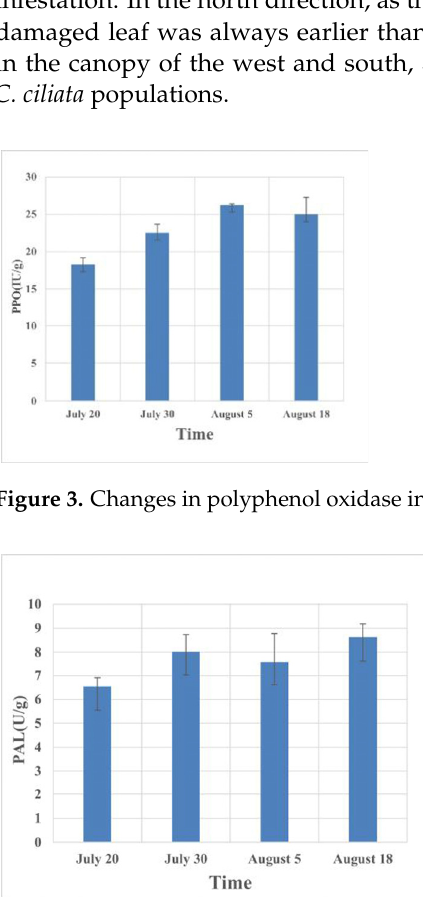
Standard Devi- Mean ± SD ation No.1